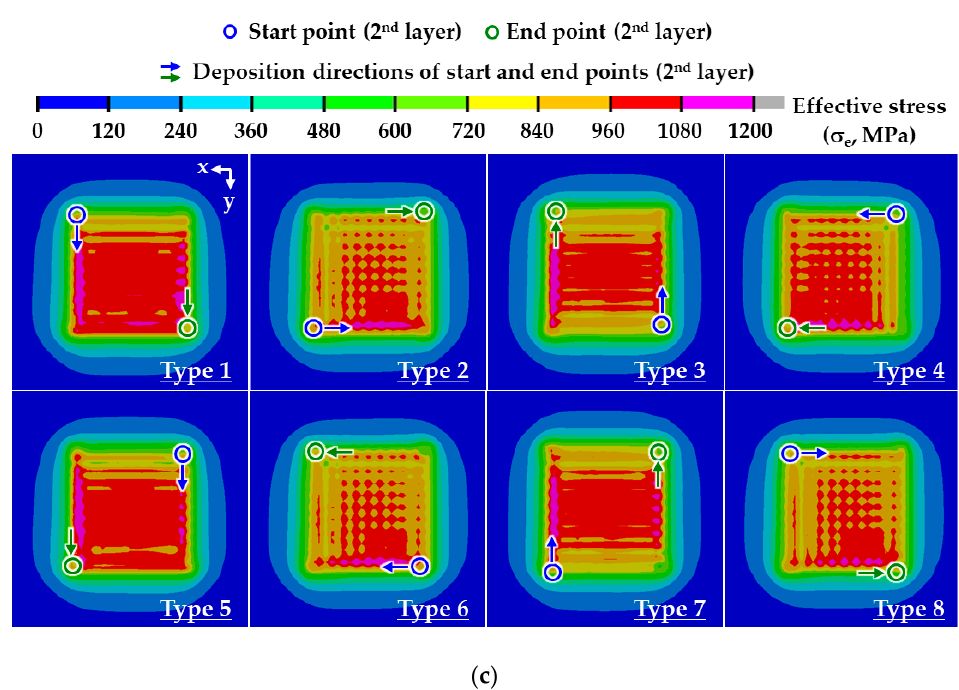
Figure 10. Effects of deposition strategies on planar effective stress distributions after the completion of cooling for a small volume deposition: ( a ) location of the plane to estimate effective stress distributions in the TD (type 1 path of ADDSs); ( b ) planar effective stress distributions (ADDS); ( c ) planar effective stress distributions (UDDS).